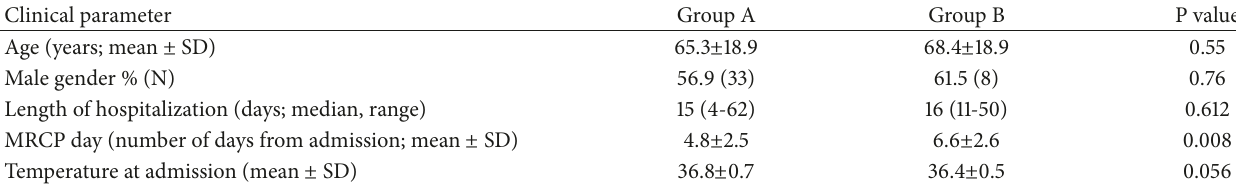
Table 1: Clinical characteristics of the study population: groups A and B.